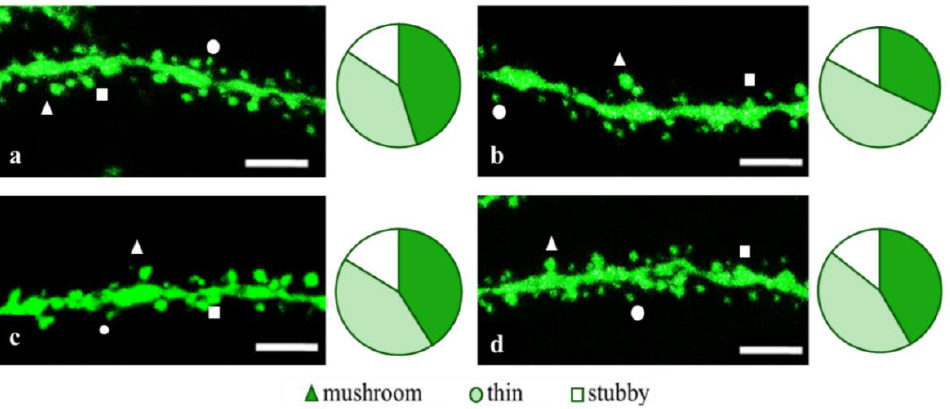
Figure 5. Confocal images of the CA1 secondary dendrites in 5 month-old male M-line ( a ) and 5xFAD-M mice, injected with a physiological solution ( b ), EDR peptide ( c ), KED peptide ( d ). Confocal microscopy, ×100. Scale bar, 10 μm.